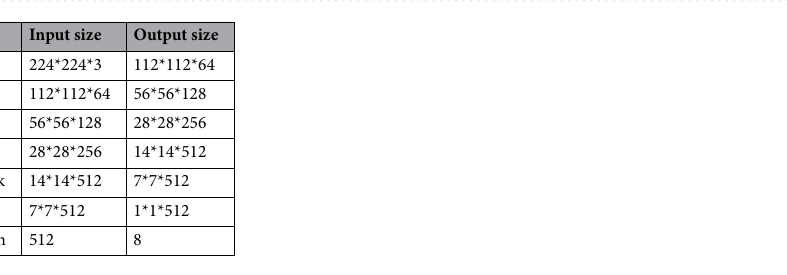
Figure 4. The overall architecture of MBSaNet.